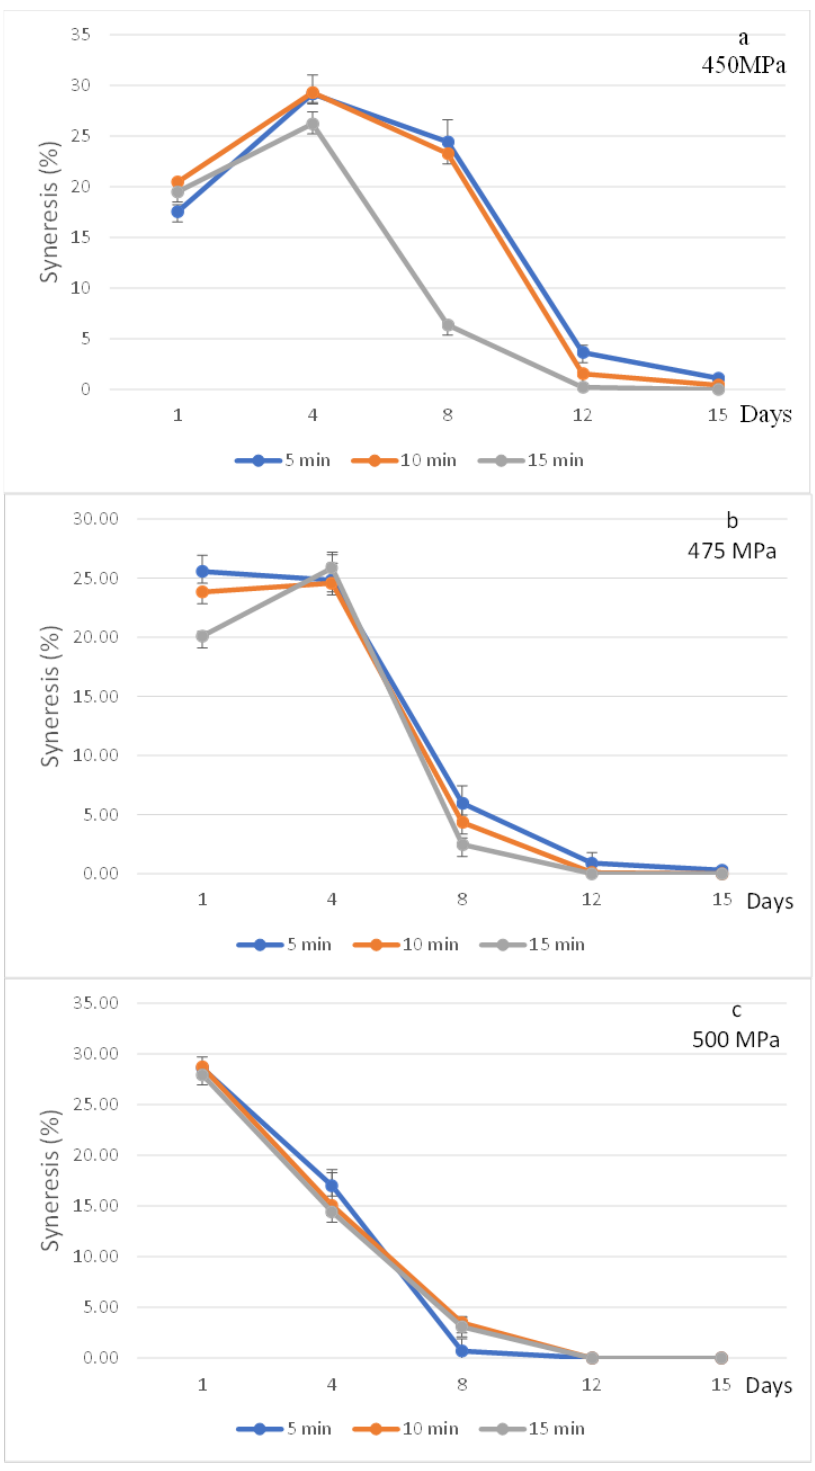
Figure 2. Effect of high-pressure and time on syneresis percentage of strawberry-flavoured egg-white pudding during 15 days storage: 450 MPa ( a ), 475 MPa ( b ), and 500 MPa ( c ).